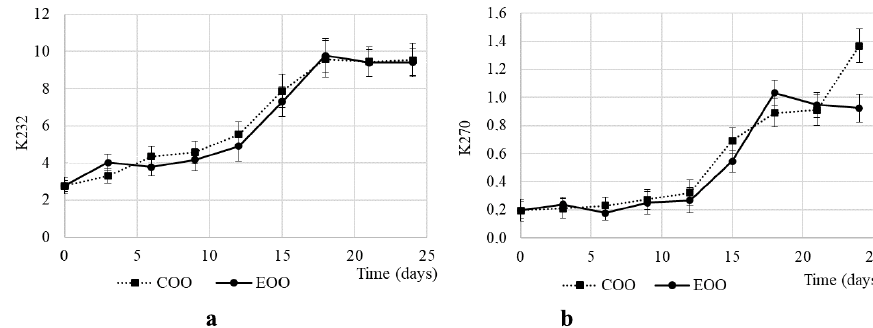
Fig. 3: Specific extinctions K232 (a) et K270 (b) of the COO and EOO under accelerated